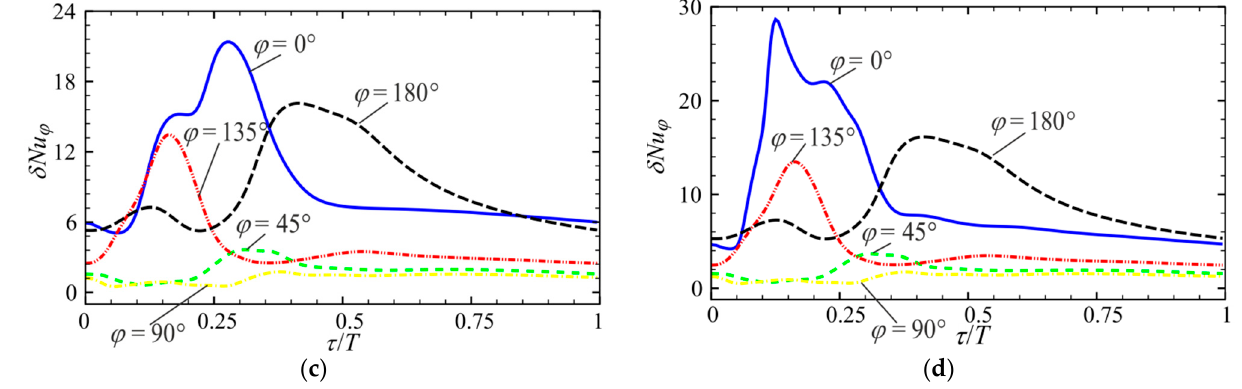
Figure 14. The effect of pulsations on the instantaneous local heat flux and velocity at f = 0.5 Hz for on period of pulsation. ( a ) Variation of effective thermal conductivity ratio δλ eff , φ = λ eff , φ , p / λ eff , φ , st with τ / T at A / D = 1.25. ( b ) Variation of δλ eff , φ with τ / T at A / D = 4.5. ( c ) Variation of the Nusselt number ratio δ Nu φ = Nu φ , p / Nu φ , st with τ / T at A / D = 1.25. ( d ) Variation of δ Nu φ with τ / T at A / D = 4.5.